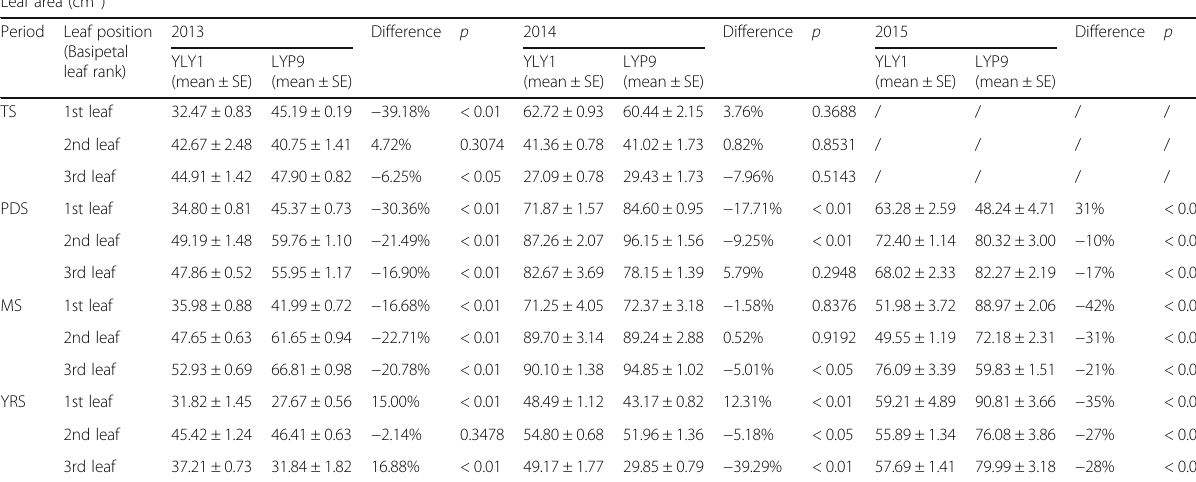
Table 5 The leaf areas of canopy eaves of main stems were measured with a handheld laser leaf area meter (Ci-203, CID, Inc., Vancouver, WA, USA) at different growth stages for cv. YLY1 and LYP9 in 2013, 2014 and 2015.n- = 10 Leaf area (cm 2